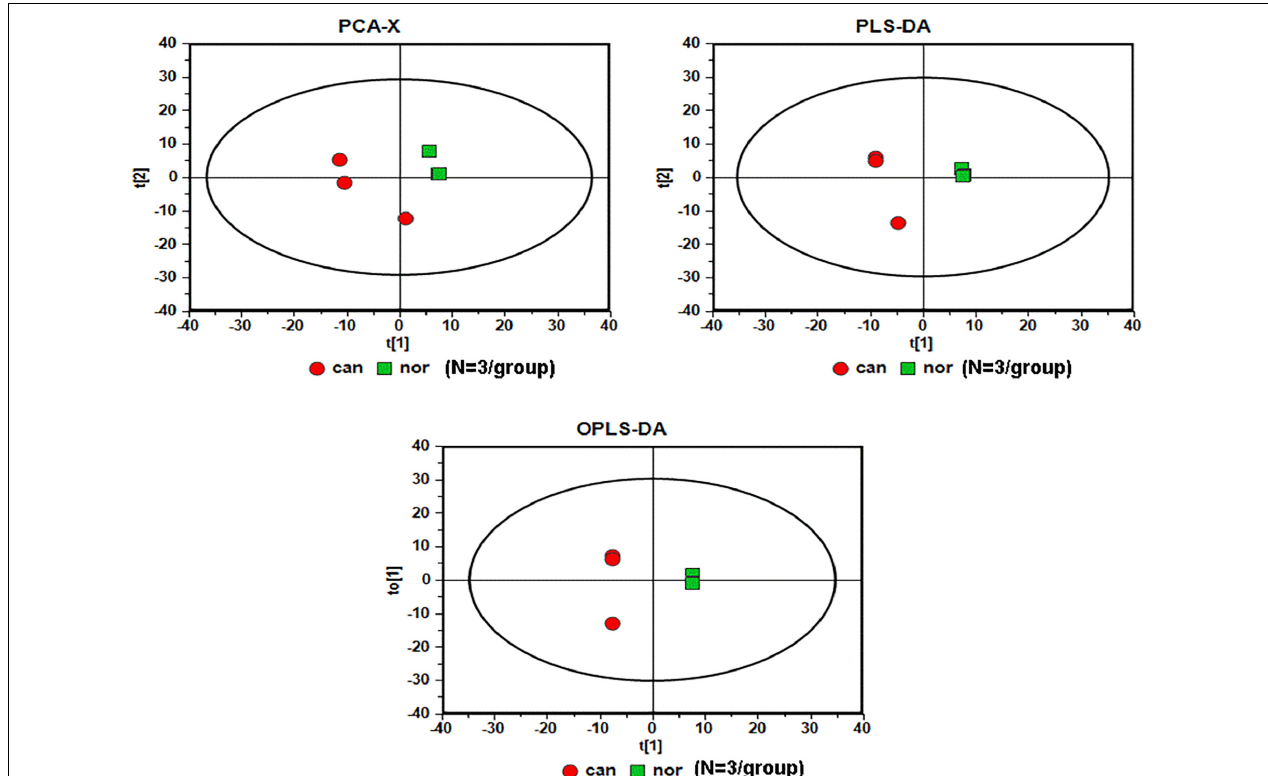
FIGURE 1 | Serummetabolic profiles derived from CRC tissues are different from those of healthy subjects ( N = 3/group). Red circles, cancer samples; green squares, normal